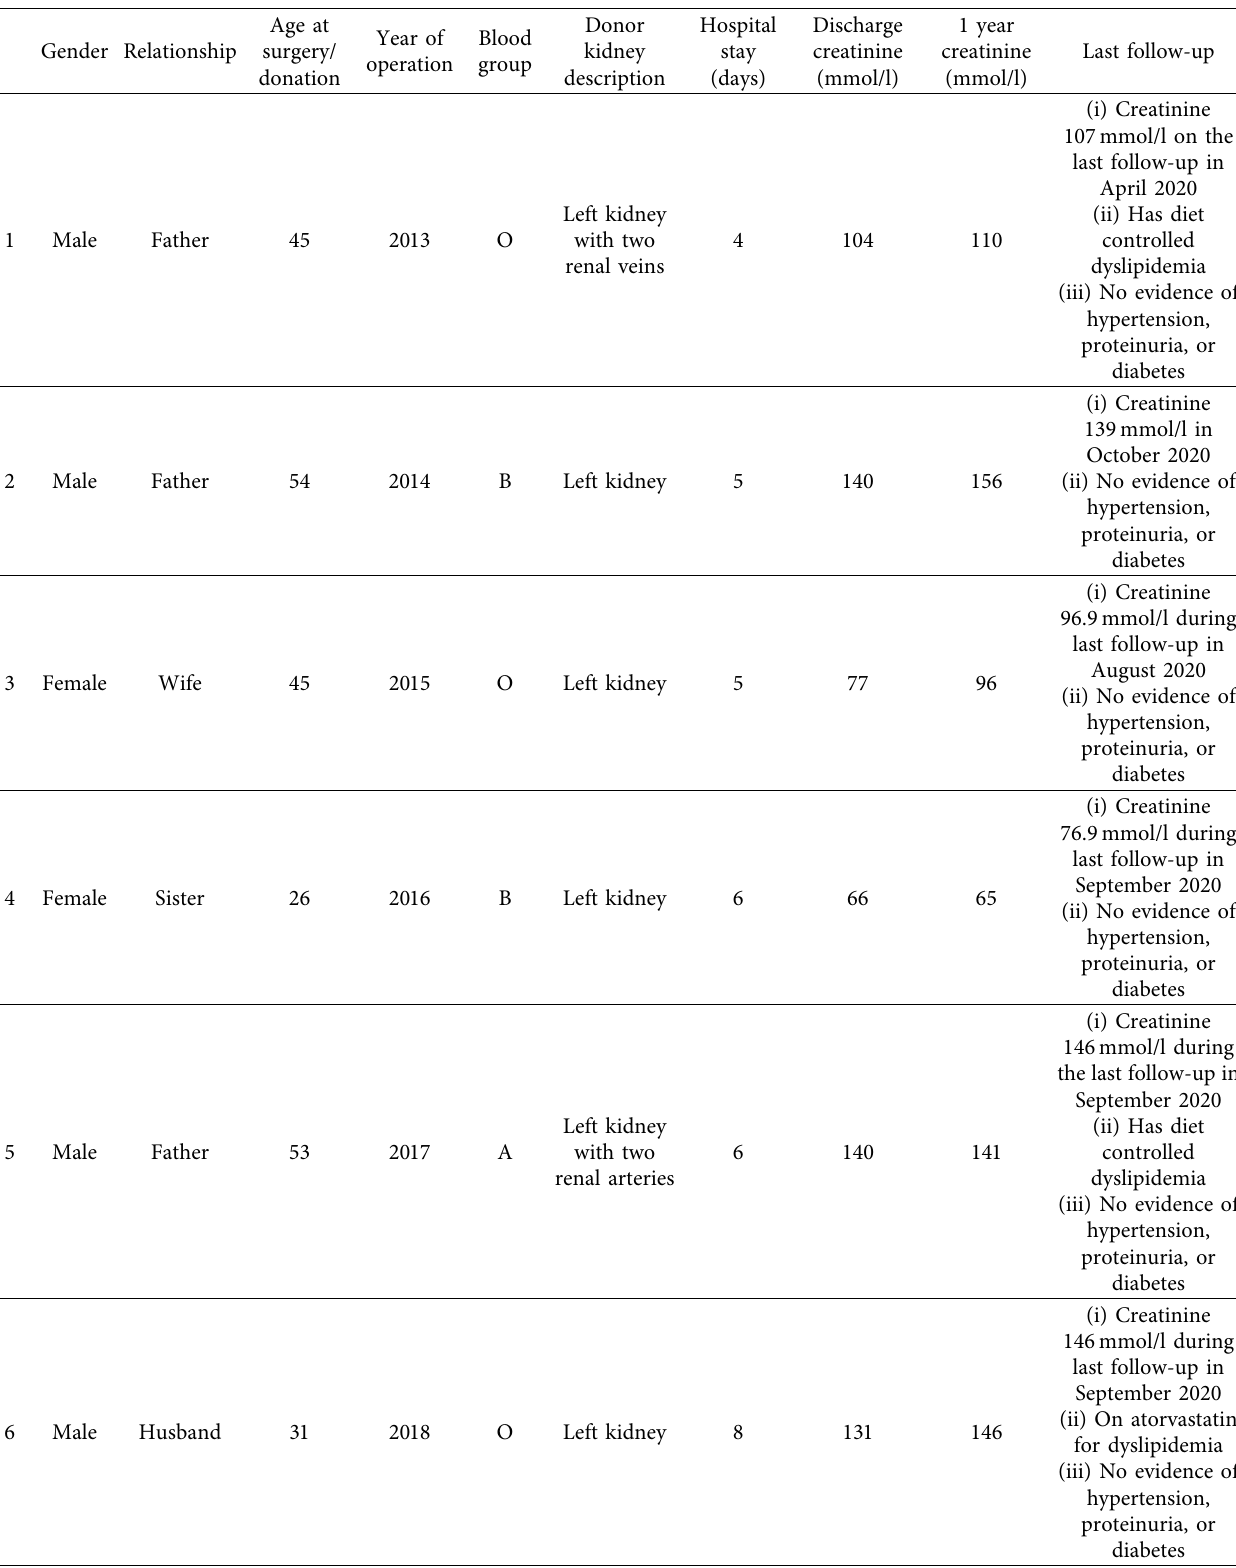
Table 4: Demographic, operative, and hospital stay details for